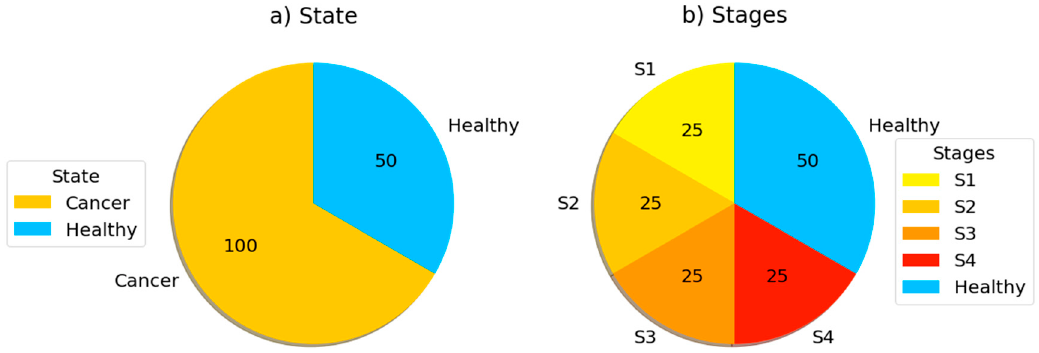
Figure 2. The distribution of data ( a ) for prediction and ( b ) for classification. (Illustrations by the authors).